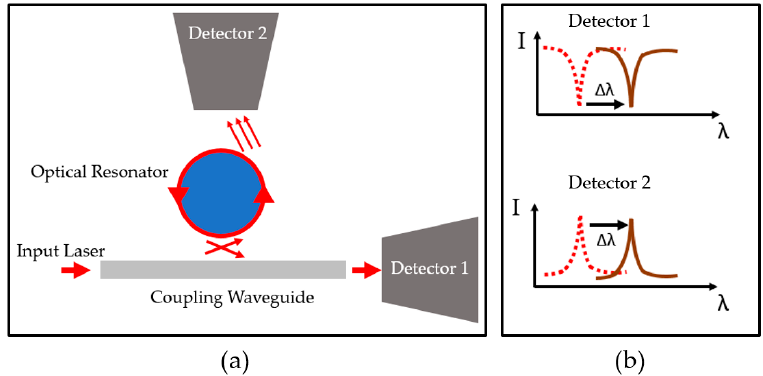
Figure 5. Diagram shows the optical resonator system and analysis. ( a ) Optical resonator system: the laser guided by a coupling waveguide excites the resonator. The detector is equipped to measure the intensity dip of the resonant wavelength at the end of the coupling waveguide (Detector 1) or scattered light (Detector 2). ( b ) Graph shows the absence of light at resonant wavelength. When the analyte binds on the surface, it causes a wavelength shift that can be observed by both modes.